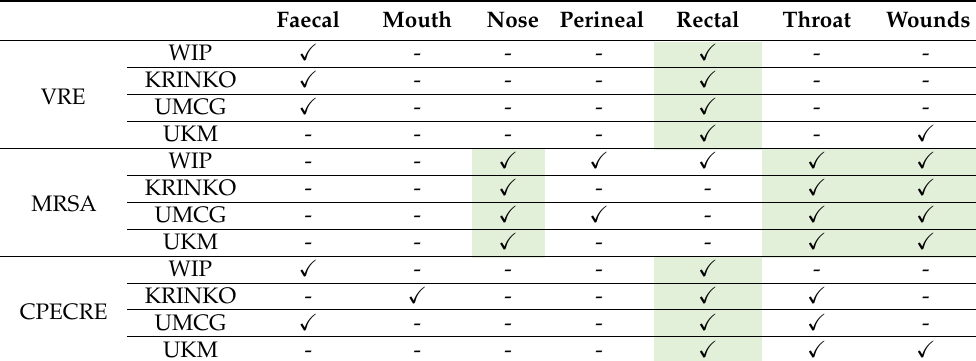
Table 2. Overview of MDRO swab-site recommendations. Faecal